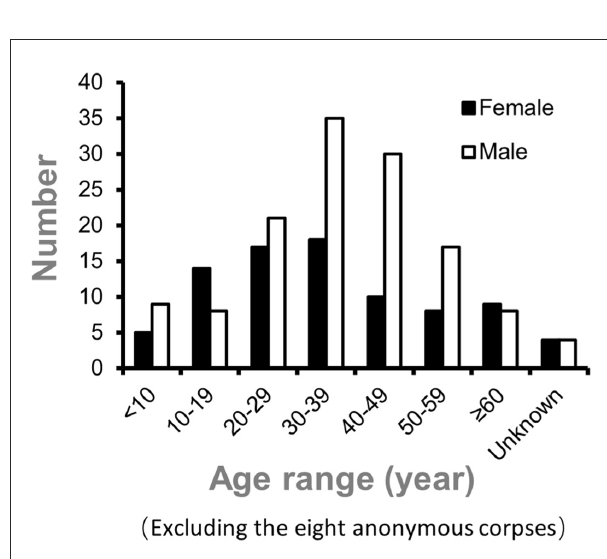
FIGURE2 Sex and age distribution of fatal intoxication cases in 1999 to